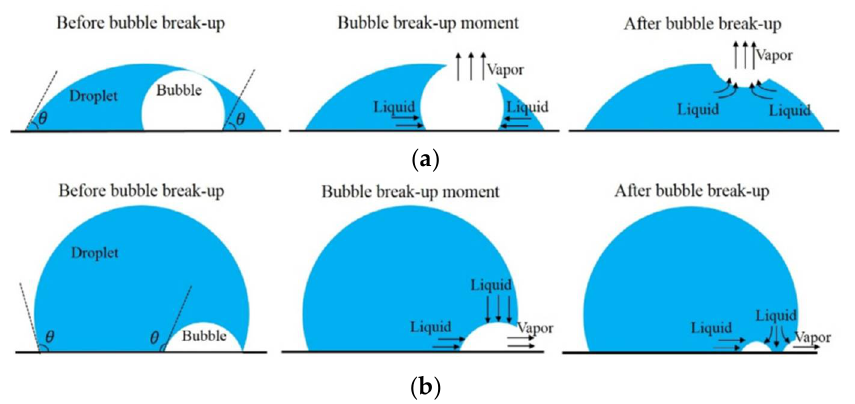
Figure 24. The process of bubble breaking within a droplet on the hydrophilic surface ( a ) and the hydrophobic surface ( b ). Reprinted with permission from Ref [117]. Copyright 2020 Elsevier.